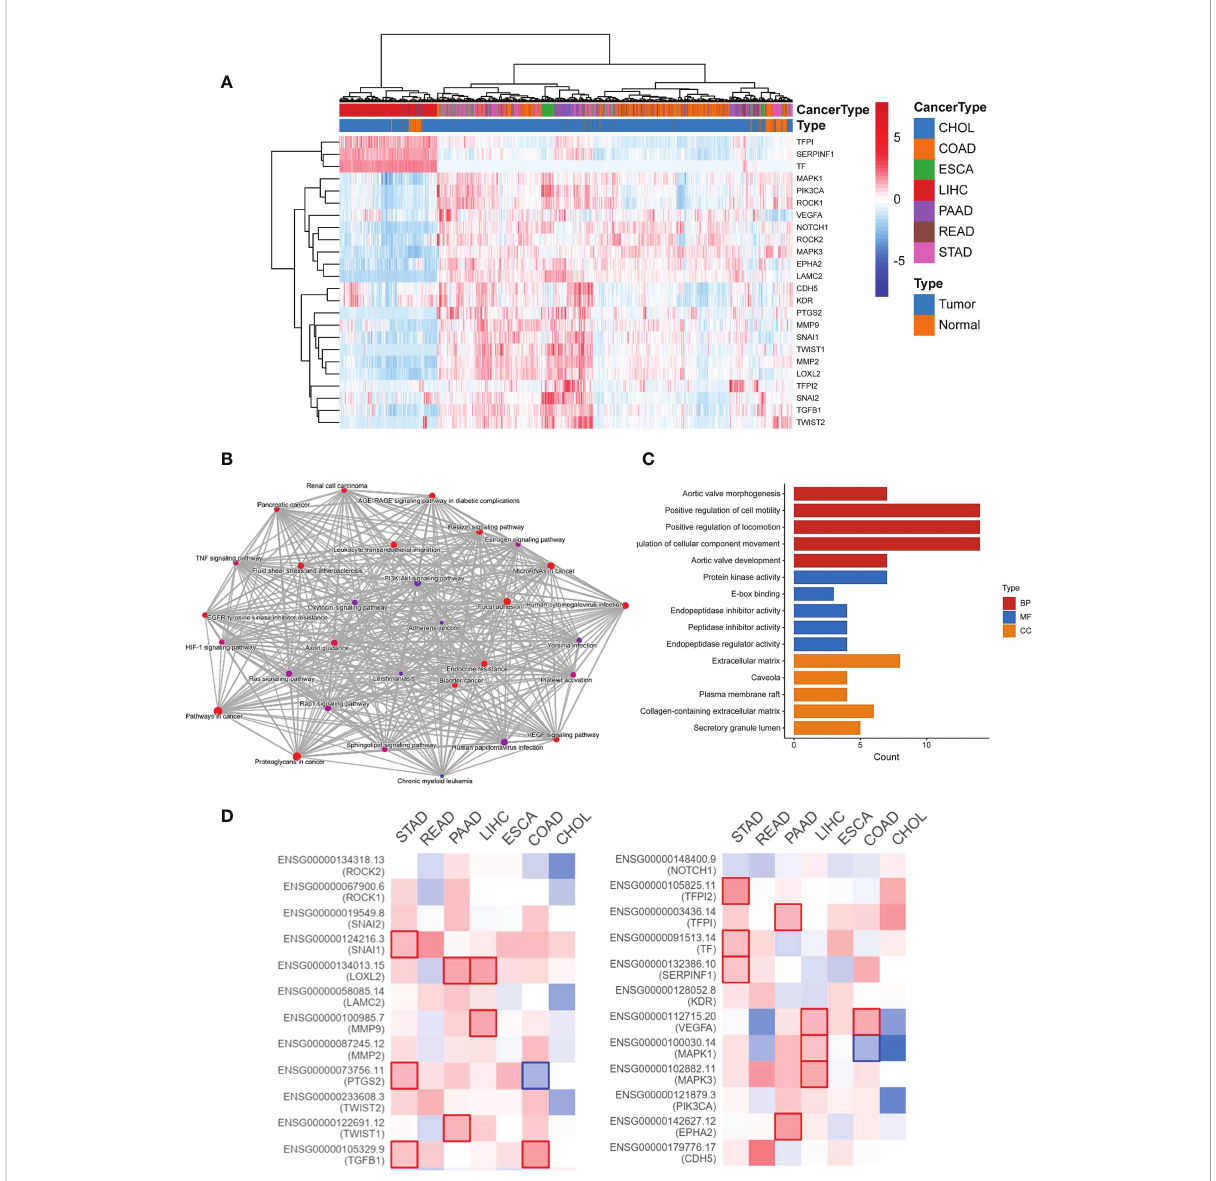
FIGURE 1 The expression and function of 24 VM-related genes in digestive system malignancies. (A) Heatmap showing the clustering in digestive system malignancy based on the expression of 24 VM-related genes. (B) Network of KEGG enriched terms colored according to clusters. (C) Gene Ontology (GO) analysis including BP, CC, and MF. BP, biological process; CC, cellular component; MF, molecular function. (D) Expression level of VM-related genes and outcomes in